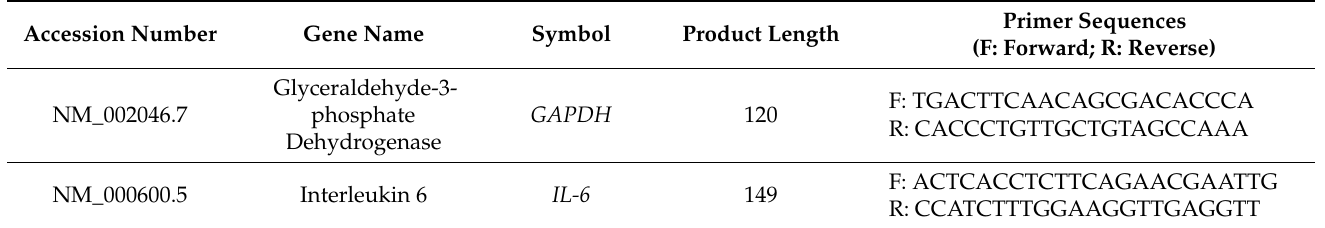
Table 1. Primer pair sequences used for the